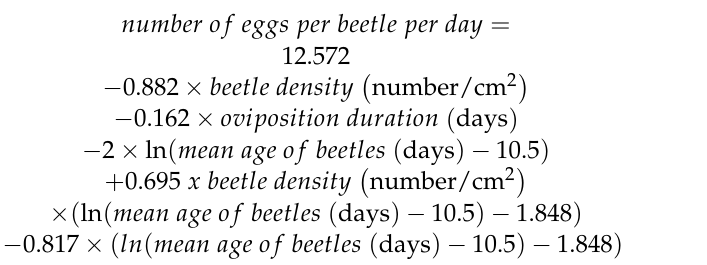
Table 5. Parameter estimates, standard error and significance level (t ratio and p -value) for multiple linear regression model of the number of eggs per beetle per day for experiment 2.